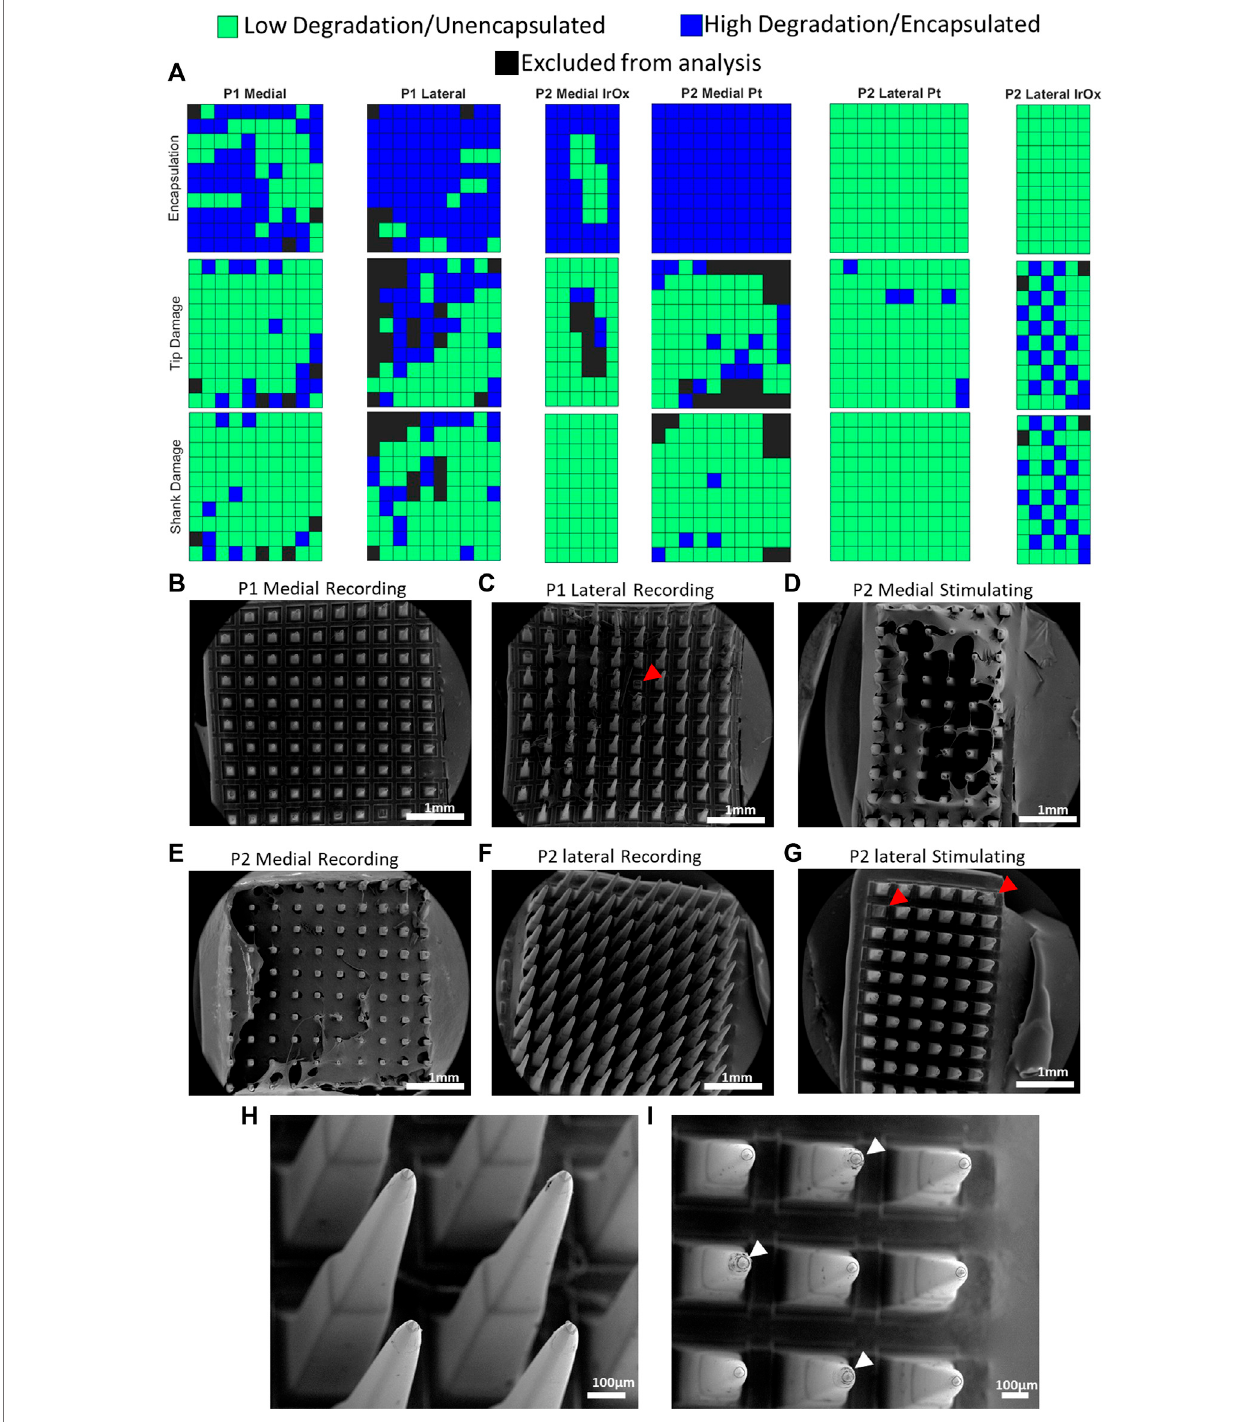
FIGURE 6 | Categories assigned to each electrode site. (A) Each site was assigned a category with respect to their material integrity or degree of encapsulation. Blacksiteswerenotabletobecategorizedandwereexcludedfromtheanalysis.EncapsulationwasdeterminedbyexaminingtheopticalimagesofthearraysforP1and SEM images for P2. This is due to the enzymatic digestion of the encapsulating tissues that was performed prior to SEM imaging for P1. (B,C) Recording arrays implanted into P1 after enzymatic treatment. (D) Medial stimulating array implanted into P2. (E,F) Medial and lateral recording arrays implanted into P2. (G) Lateral stimulatingarrayimplantedintoP2. (H,I) Highermagni fi cationimagesofrecordingarrayin (F) andstimulatingarraysin (G) ,respectively.Whitearrowsindicateelectrodes which were used for stimulation. Red arrows indicate representative electrodes which were excluded from analysis.